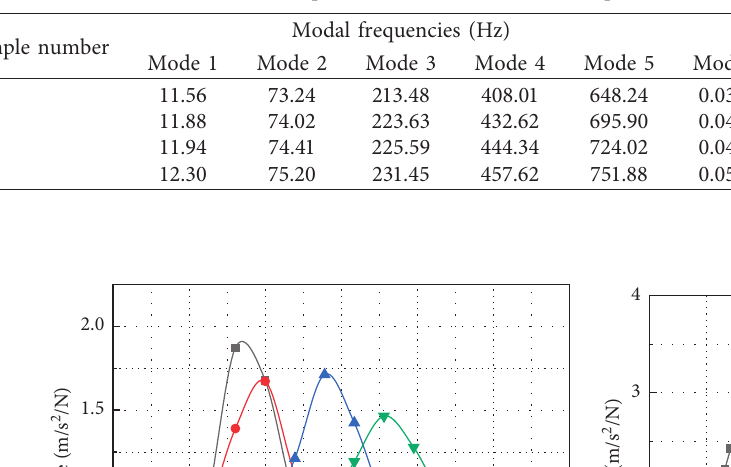
Table 4: Modal frequencies and loss factors of samples 1# ∼ 4# (experimental temperature: 23.5 °